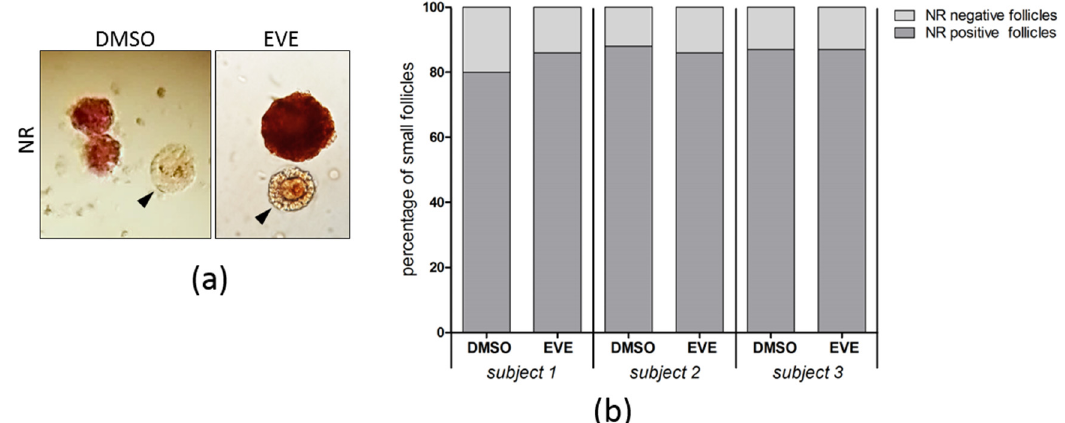
Figure 7. Follicular viability after 24 h of purging with Everolimus. ( a ) Ovarian tissue from 3 individuals exposed for 24 h to EVE or solvent only was cultured for an additional 24 h and assayed by Neutral Red (NR)staining of follicles. For each condition 100 small follicles were evaluated. Follicles staining bright red were considered intact and viable, unstained or very faint stained follicles (black arrowheads) were scored as damaged. ( b ) The percentage of Neutral Red positive and negative small follicles was comparable for tissue purged with EVE or tissue treated with solvent only.